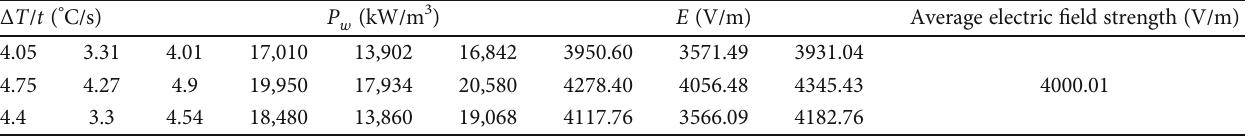
Table 2: Calculation results of the electric fi eld intensity of the water cup load experiment.